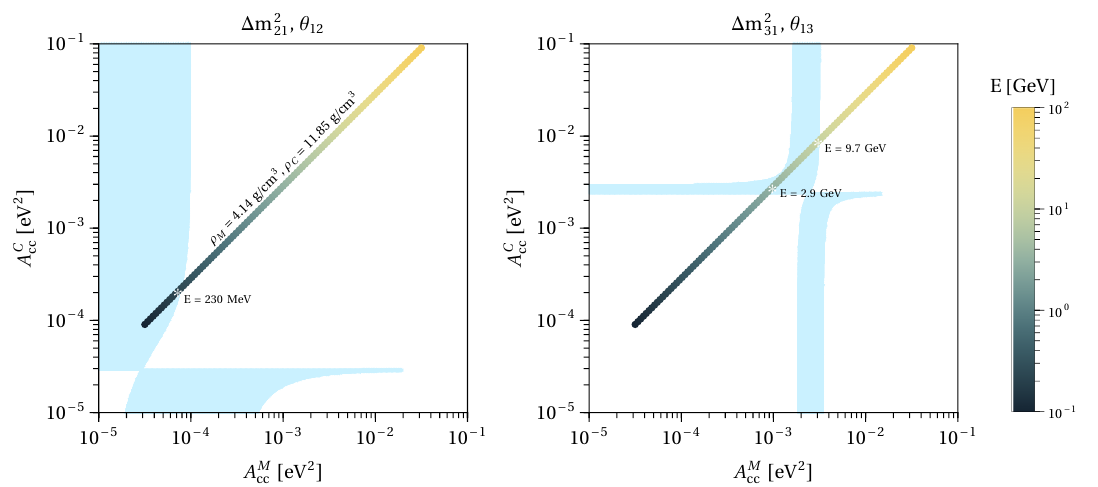
, X = M , C , that could lead to a parametric resonance assuming the solar Figure 2 . Values of A X CC (left) and atmospheric (right) oscillation parameters. The light blue region corresponds to the values that fulfill the conditions (2.14). The diagonal colored region corresponds to the values of A that CC are present for the core and mantle densities ( ρ = 11 . 85 g cm − 3 , ρ = 4 . 14 g cm − 3 ) as function of C M the neutrino energy.